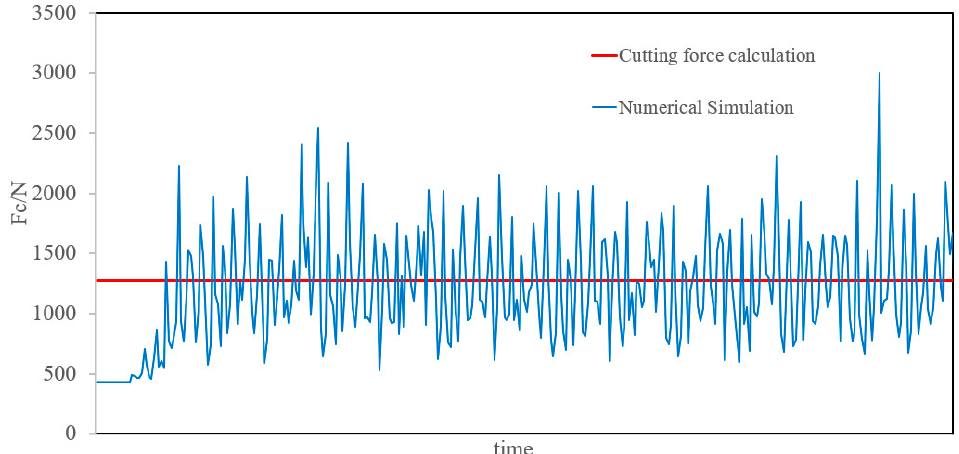
Figure 6. Comparison of numerical simulation ( F c) and cutting force calculation ( F c *).